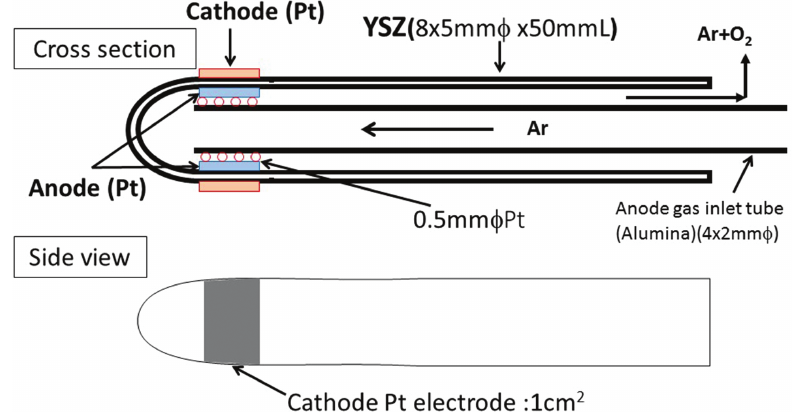
Figure 2: Cross section and side view of tube-type